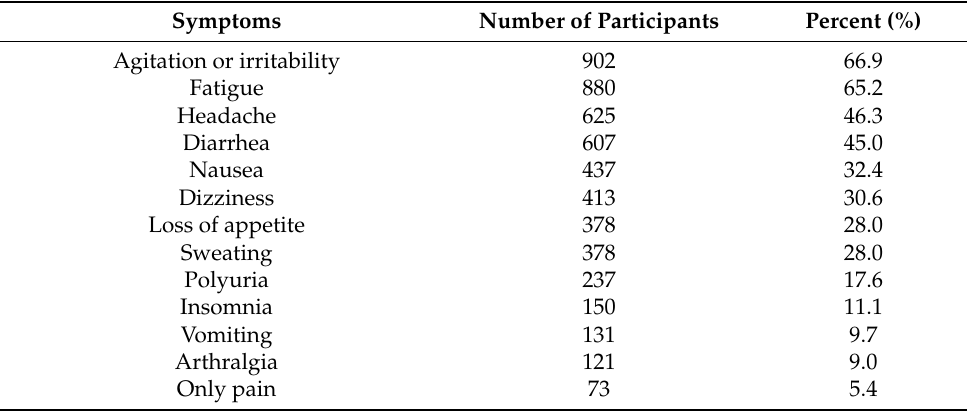
Table 3. Symptoms Associated with Dysmenorrhea ( n =